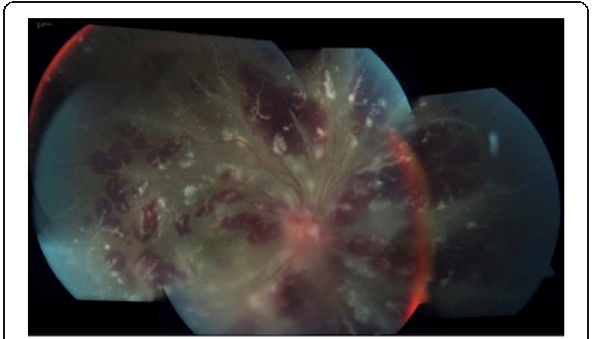
Fig. 4 Composite color fundus photograph of the right eye shows widespread retinal vasculitis with perivascular exudates, optic disc swelling, macular edema and diffuse retinal hemorrhages, characterizing frosted branch angiitis in a patient with secondary antiphospholipid syndrome from systemic lupus